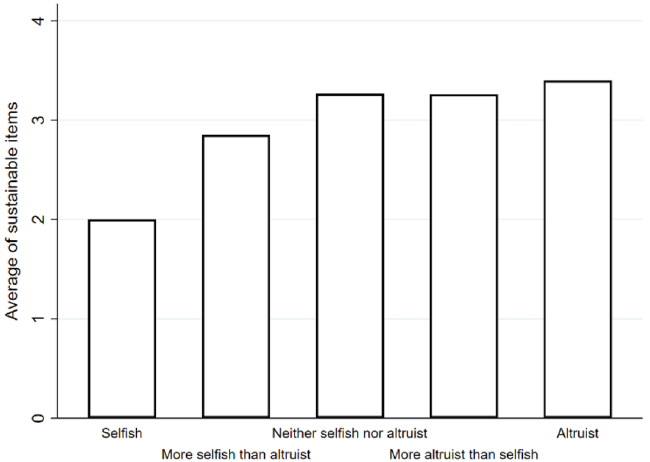
Figure 1. Mean values for each degree of altruism, in relation to the index of sustainable